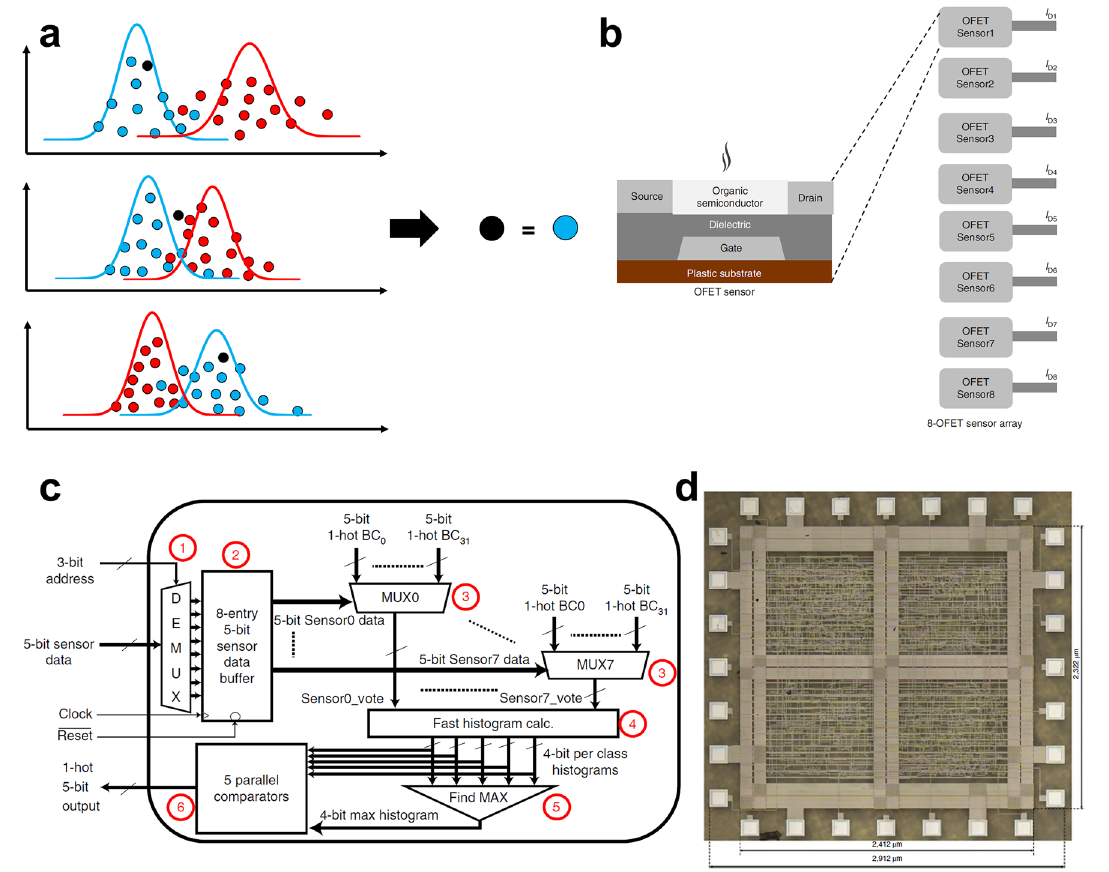
Fig. 18 Signals detected by the soft system and processed by GNB based on soft chip. a Schematic diagram of GNB. b Schematic diagram of a single OFET sensor and an e-nose sensor array containing eight OFET sensors. c Microarchitecture of the UB-FVC inference stage. Five-bit sensor data are received serially and demultiplexed (block 1) into the sensor data buffer (block 2). Each feature is implemented as a multiplexor (blocks 3). Then, a fast histogram count calculation is performed by Block 4 for the eight BCs or votes. The highest histogram value is calculated through a comparator reduction tree (‘Find MAX’ block 5). Five parallel comparators (block 6) take the five histogram values and compare each one with the highest histogram value from block 5 to find the statistical mode. d Micrograph of the NFPE implementing the UB-FVC